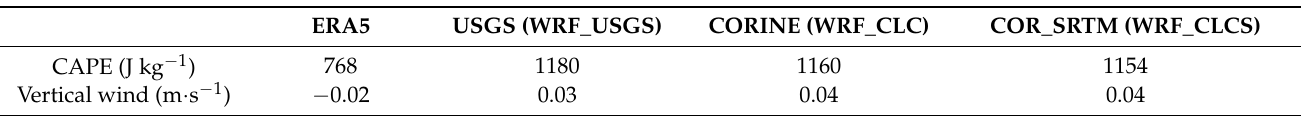
Figure 11. Comparison of the vertical wind at pressure level 850 hPa from ERA5 ( a ), USGS ( b ), Corine ( c ) and Corine + SRTM at 12 UTC on 18 August 2011. Table 3. Domain-wide median values of CAPE and the vertical wind among the ERA5, USGS, Corine and Corine + SRTM at 12 UTC on 18 August